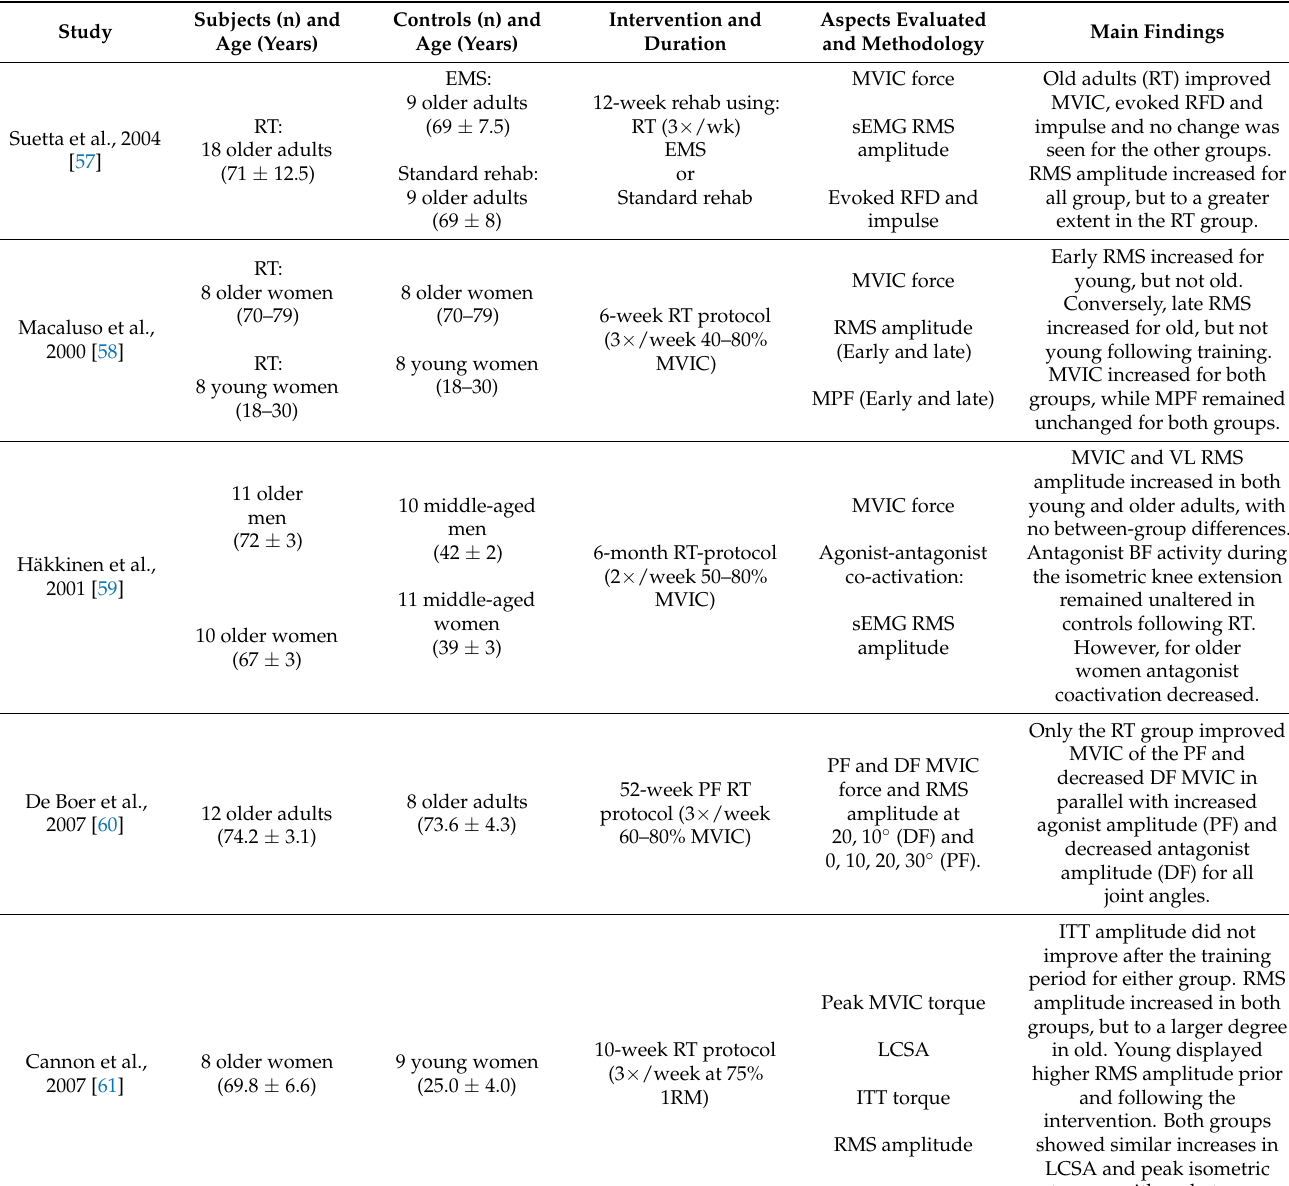
Table 3. Resistance training studies evaluating EMG parameters following RT in older